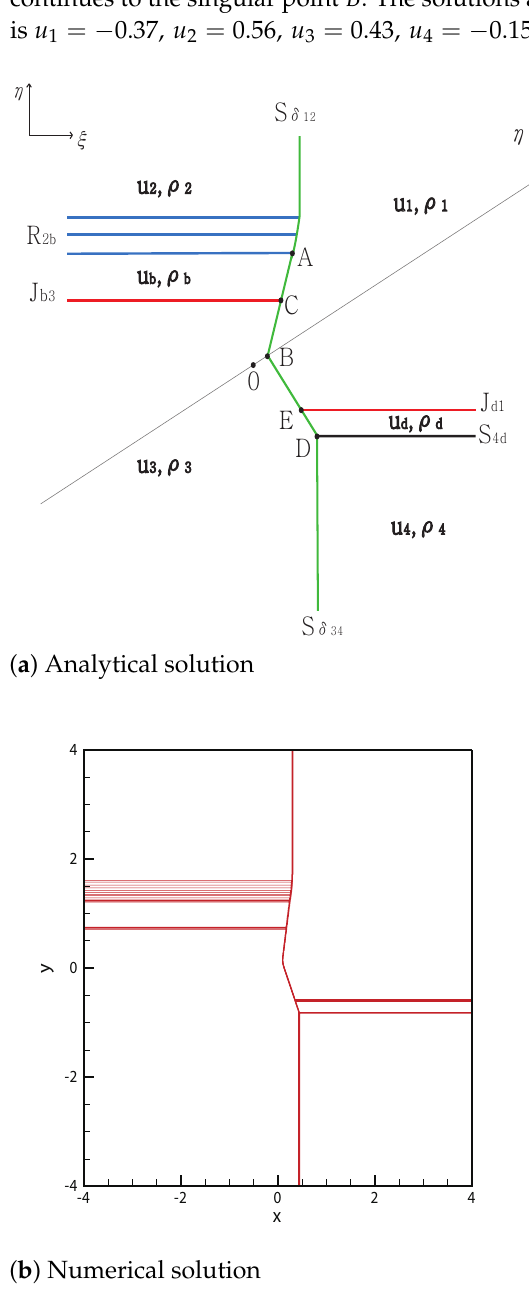
Figure 5. Case 5. S δ + RJ + S δ + SJ